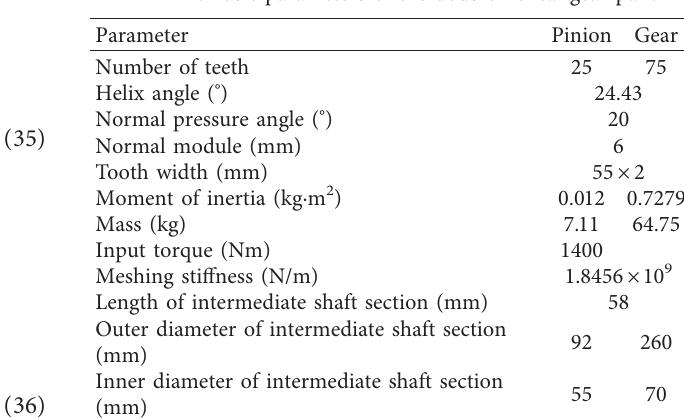
Table 1: Basic parameters of the double-helical gear